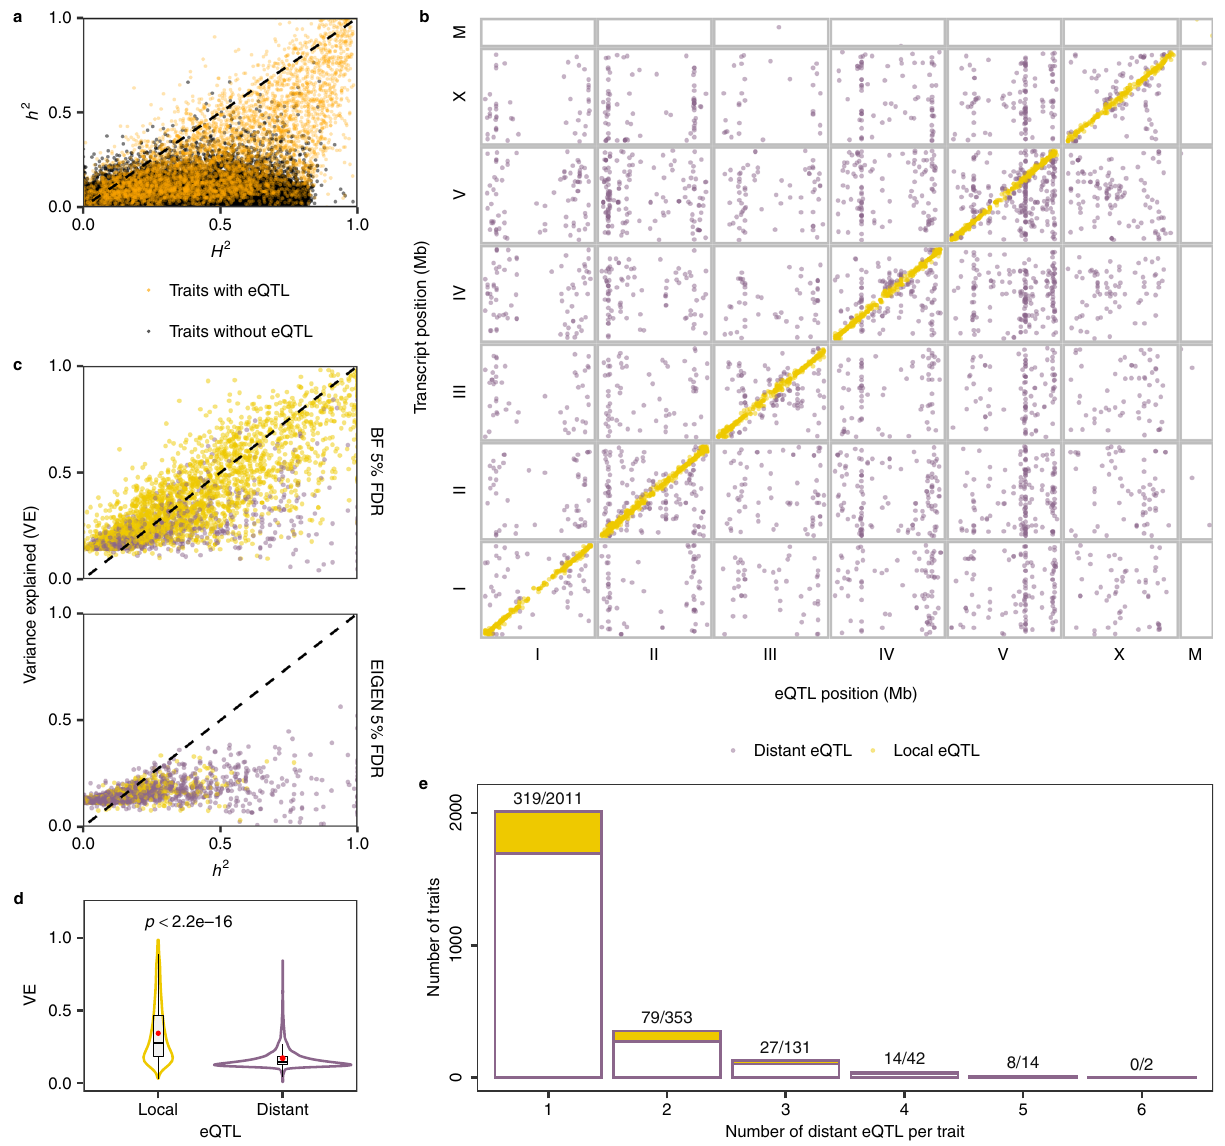
Fig. 2 Expression QTL map of 207 wild C. elegans strains. a Heritability for 25,849 transcript expression traits with (orange) or without (black) detected eQTL. The narrow-sense heritability ( h 2 , y-axis) for each trait is plotted against the broad-sense heritability ( H 2 , x-axis). b The genomic locations of 6,545 eQTL peaks (x-axis) that pass the genome-wide EIGEN 5% FDR threshold are plotted against the genomic locations of the 5,291 transcripts with expression differences (y-axis). Golden points on the diagonal of the map represent local eQTL that colocalize with the transcripts that they in fl uence. Purple points correspond to distant eQTL that are located farther away from the transcripts that they in fl uence. c The variance explained (VE) by each detected eQTL ( y -axis) that passed Bonferroni (BF) 5% FDR or EIGEN 5% FDR threshold for each trait is plotted against the narrow-sense heritability h 2 ( x - axis). The dashed lines on the diagonal are shown as visual guides to represent h 2 = H 2 ( a ) and VE = h 2 ( c ). d Comparison of VE between 3185 local and 3,360 distant eQTL shown as Violin plots. The mean and median VE by local or distant eQTL are indicated as red points and horizontal lines in each box, respectively. Box edges denote the 25th and 75th quantiles of the data, and whiskers represent 1.5× the interquartile range. Statistical signi fi cance was calculated using a two-sided Wilcoxon test. e A histogram showing the number of distant eQTL detected per transcript expression trait. One to six distant eQTL were detected for 2,553 transcript expression traits, of which 447 traits also have one local eQTL. Numbers before slashes (indicated as the golden proportion of each bar) represent the number of traits with a local eQTL in addition to their distant eQTL. Numbers after each slash represent the total number of traits in each